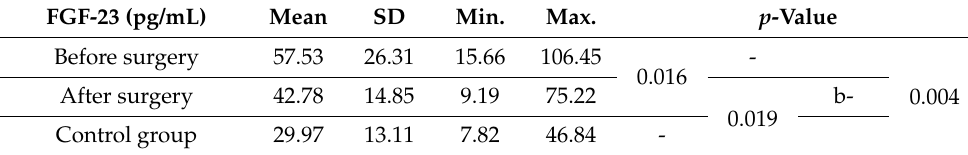
Figure 2. Determination of optimum cut-off point for FGF-23 using ROC (receiver operating char- acteristic) curve. Table 2. Plasma concentrations of FGF-23 in study group vs. control group.